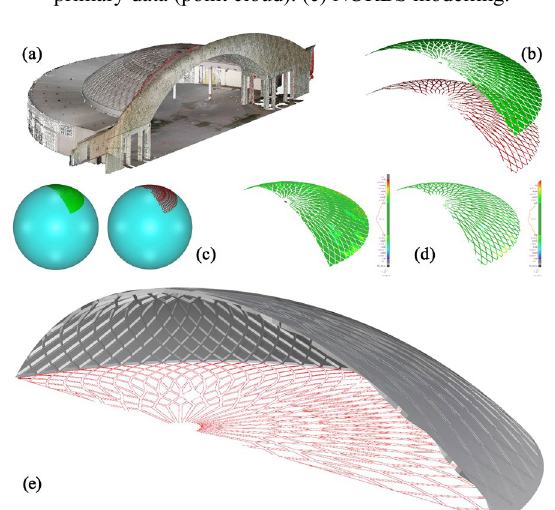
Figure 11 . (a) LiDAR point cloud (Hall B apse and dome); (b) Segmented point cloud (dome and ribs intrados). (c) Best-fitting spheres (least squares interpolation); (d) Discrepancies analyses between the interpolated spheres and the original point cloud; (e) NURBS